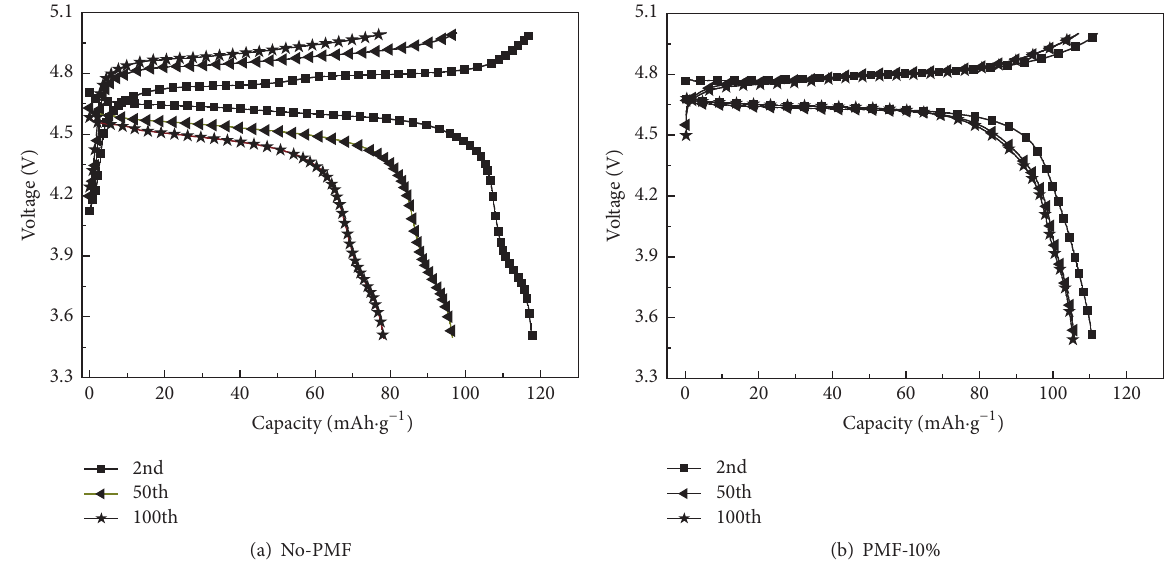
Figure 4: The charge and discharge curves of prepared LiNi 0.5 Mn 1.5 O 4 at 10C.